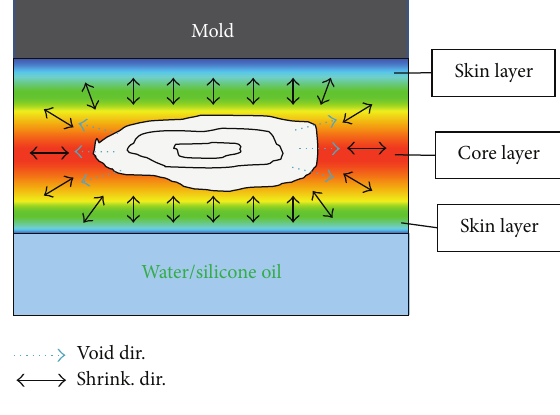
dir.Void dir. Shrink. Figure 2: Mechanism of void formation.